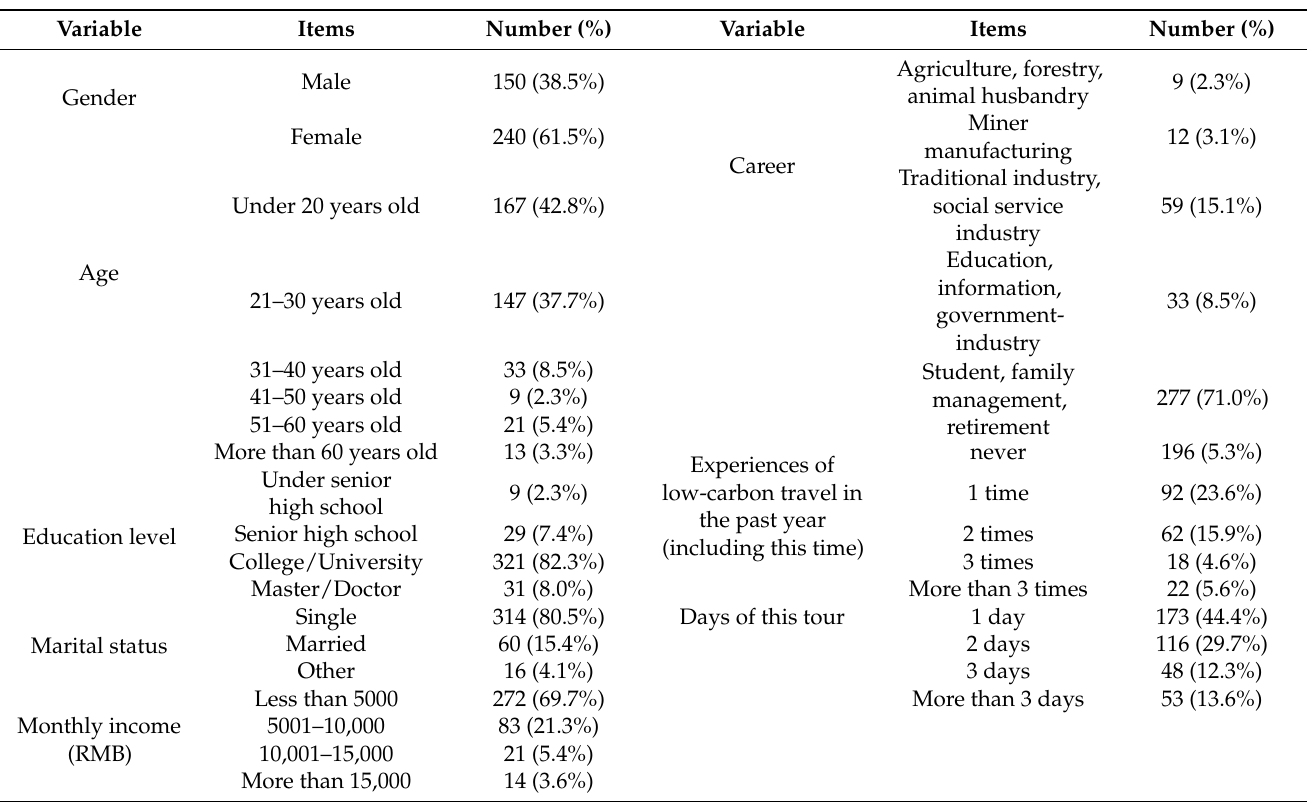
Table 4. The second sample’s profile and travel characteristics—from non-low-carbon destinations ( n =